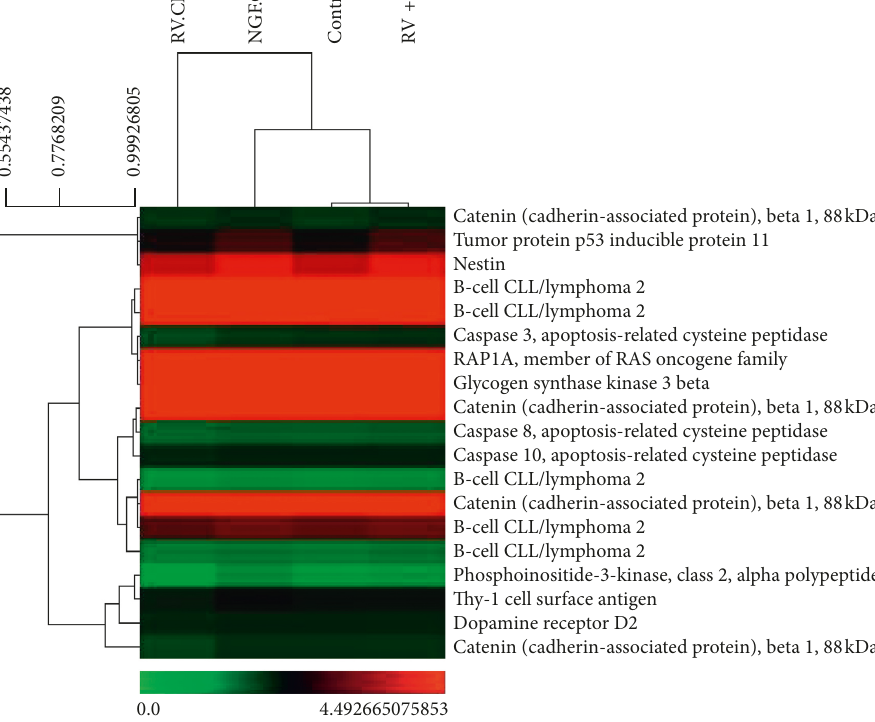
Figure 4: Clustering result of significant genes.